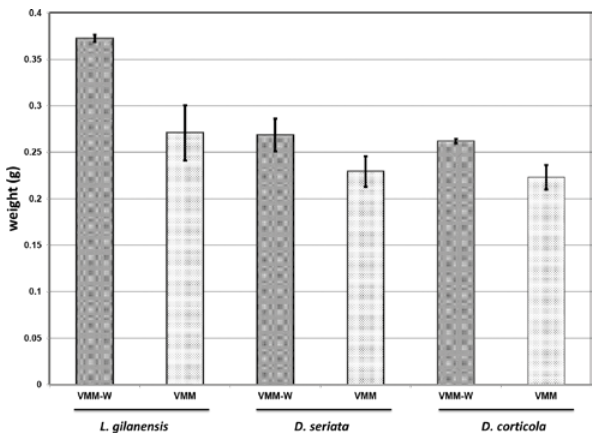
Figure 2. Mean weight of biomass of Lasiodiplodia gilaniensis , Dip- lodia seriata or D. corticola grown on Vogel’s Minimum Medium in the presence (VMM-W) or the absence (VMM) of grapevine wood. There was a strong effect for the presence of grapevine wood for L. gilaniensis .